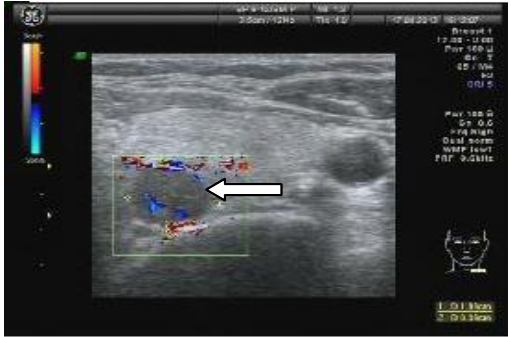
Fig. 2 99m Tc-MIBI SPECT-CT image of parathyroid gland hyperplastic nodules in the upper rear medium of left lobe of the parathyroid gland (cross)